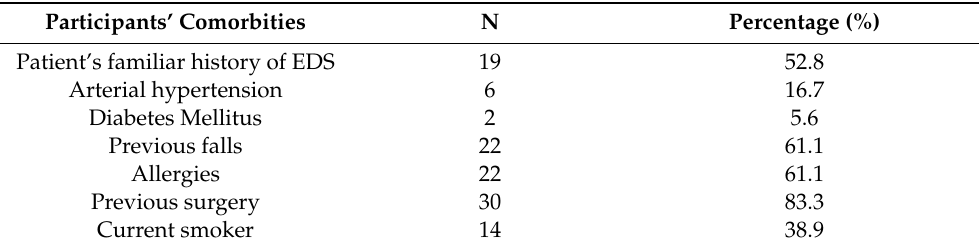
Table 1. Participants’ comorbidities.